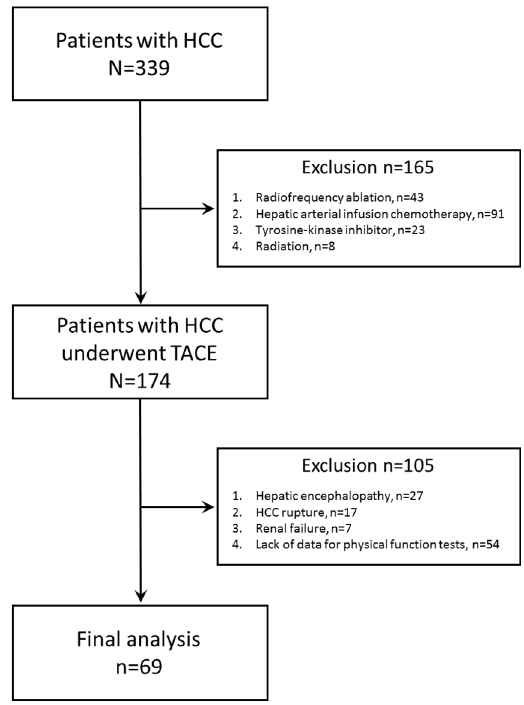
Figure 1. A flow diagram of analyzed subjects.